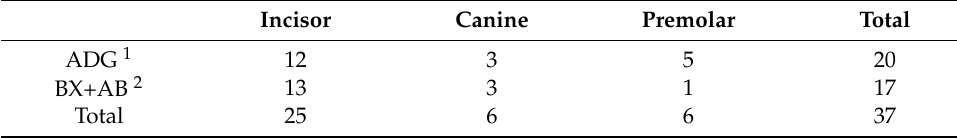
Table 2. Distribution of maxillary extraction sites. Incisor Canine Premolar Total ADG